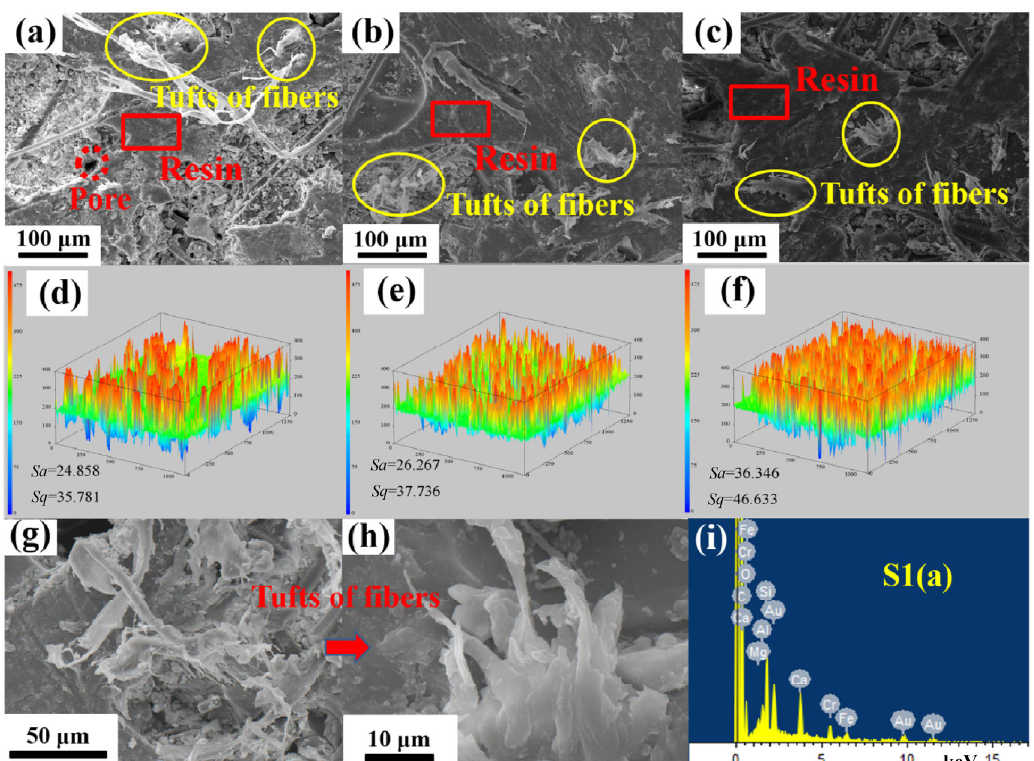
Fig. 3 SEM images of (a) S1, (b) S2 , and (c) S3 before wear. Corresponding 3D surface profiles of different samples: (d) S1, (e) S2 , and (f) S3 . (g, h) High-magnification SEM images of fibers, and (i) energy disperse spectroscopy (EDS) spectroscopy for